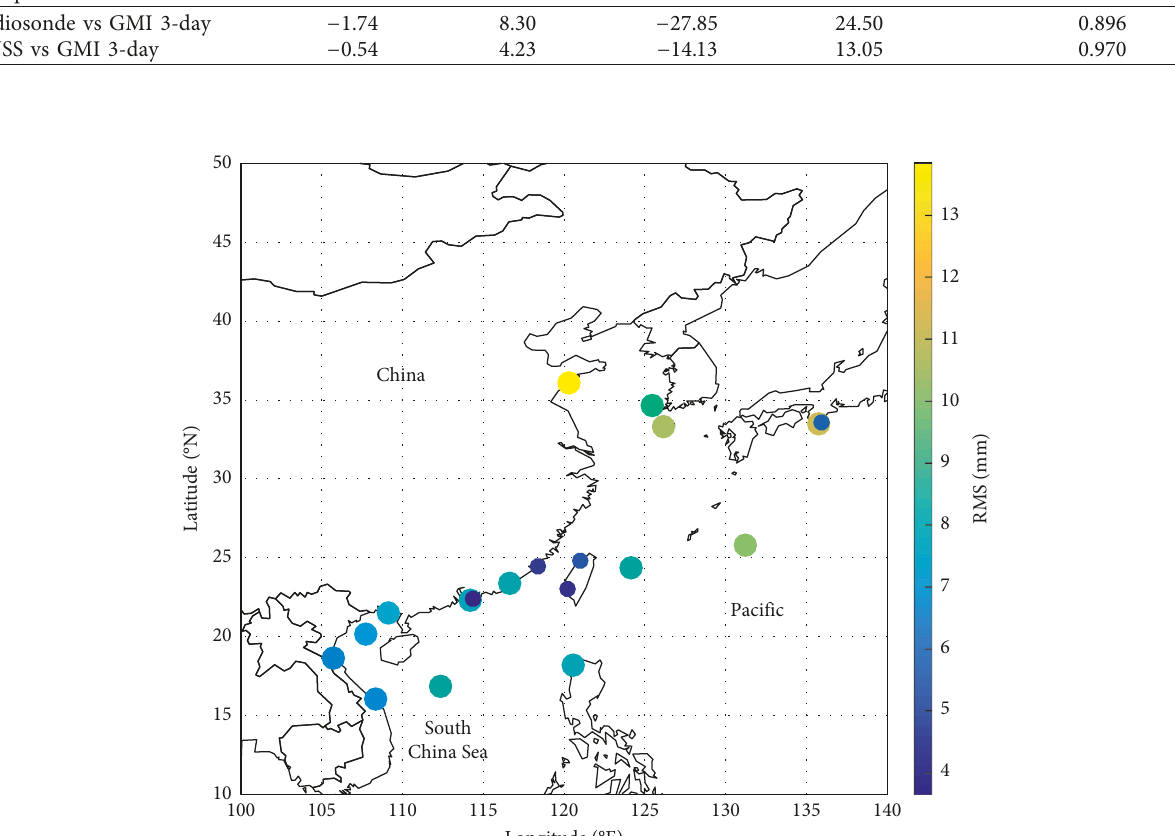
Figure 4: RMS errors of the PWV differences between GMI 3-day and radiosonde (big circles) and between GMI 3-day and GNSS (small